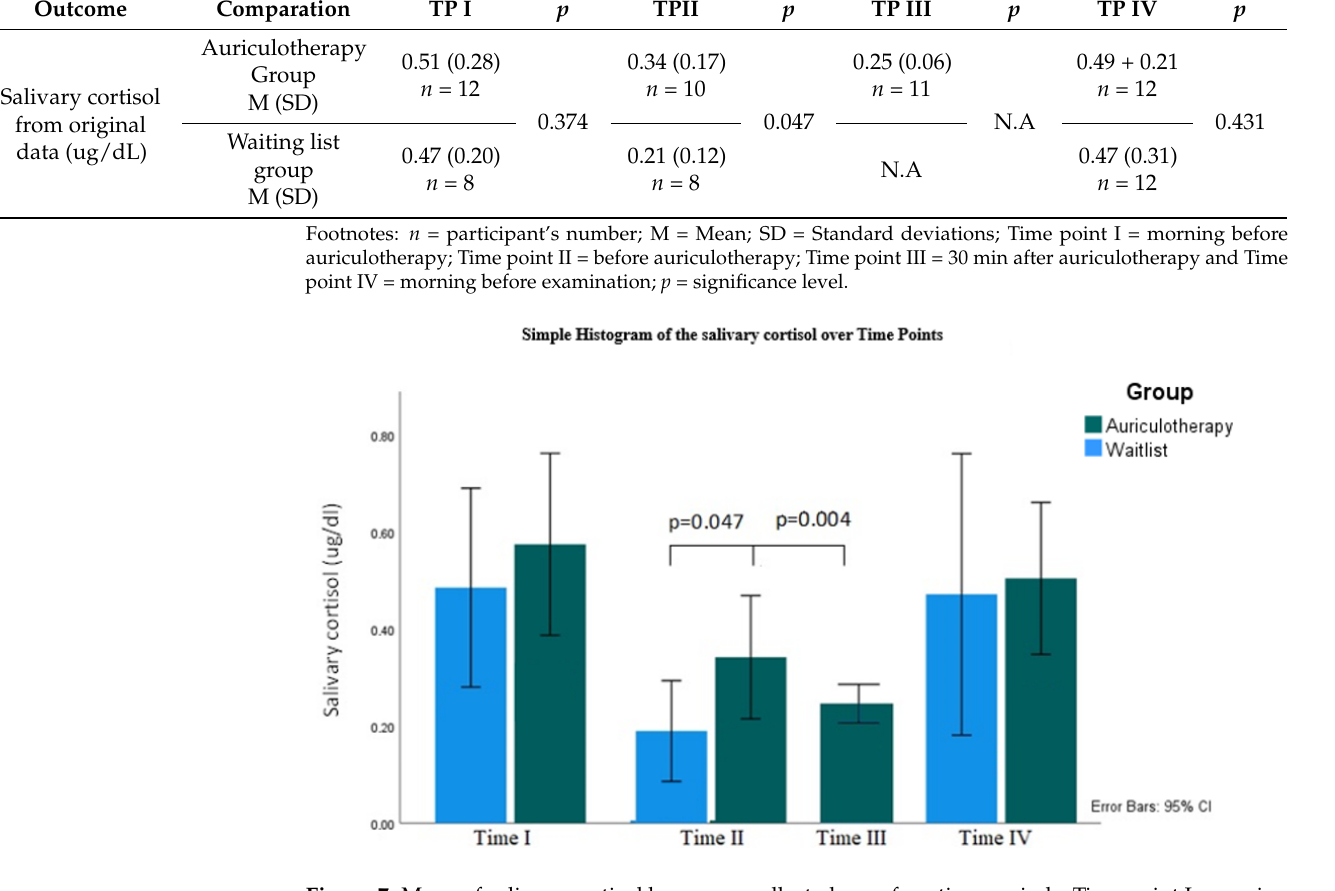
Figure 7. Mean of salivary cortisol by group, collected over four time periods, Time point I: morning before auriculotherapy; Time point II: before auriculotherapy; Time point III: 30 minutes after auriculotherapy and Time point IV: morning before examination, CI: confidence interval